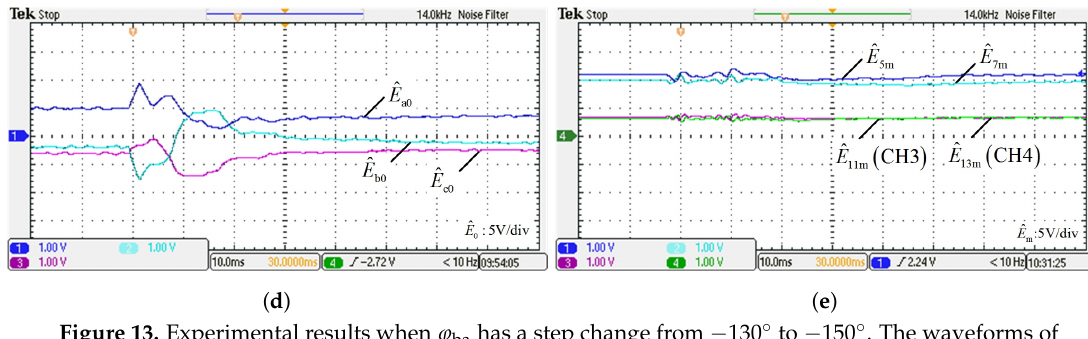
Figure 13. Experimental results when ϕ ba has a step change from − 130 ◦ to − 150 ◦ . The waveforms of ( a ) e abc ; ( b ) ˆ f , ˆ ϕ ba , and ˆ ϕ ca ; ( c ) ˆ e abc and ˆ θ a ; ( d ) ˆ E abc0 ; ( e ) ˆ E 5m , ˆ E 7m , ˆ E 11m , and ˆ E 13m .